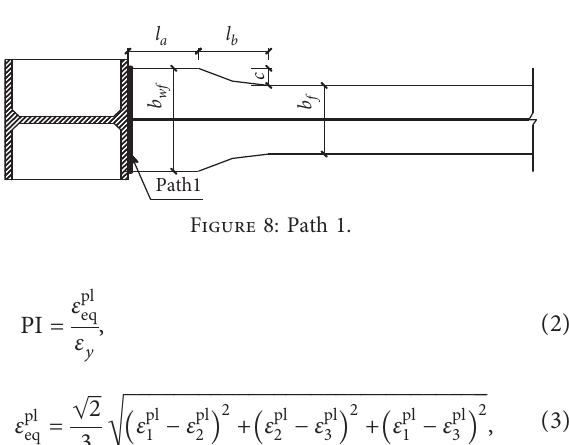
Figure 6: Skeleton curves. (a) WF-1A. (b) WF-1B.